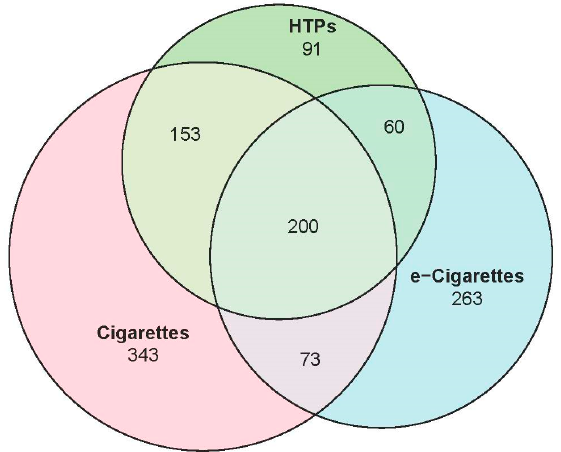
Figure 2. The number of current users of any products, Grade 7–12, male and female. In total, n = 1183 (1.8%; N = 64,152) The overlap areas represent those who used both or all; the non-overlap area indicates the total number of students who used each product exclusively. Abbreviations: HTPs = heated-tobacco-products.